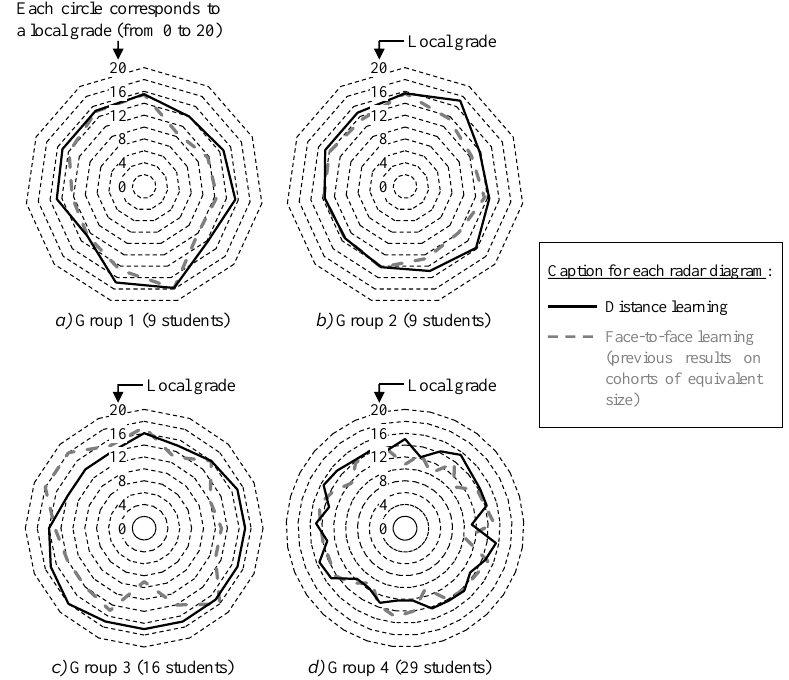
Fig. 2. Comparison of student performance in face-to-face and distance education: a) Group 1 (9 students); b) Group 2 (9 students); c) Group 3 (16 students); d) Group 4 (29 students)